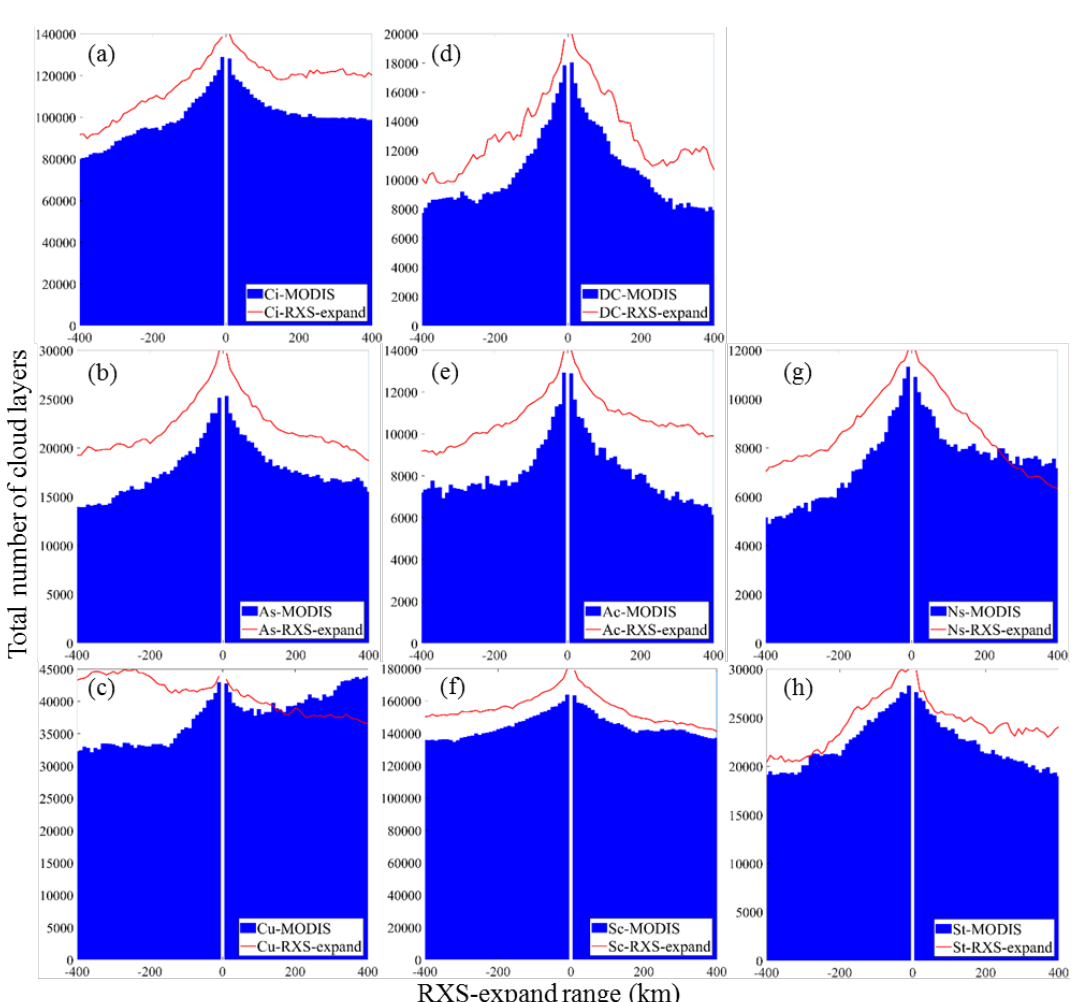
Figure 11. Comparison between cloud identification from MODIS and from the RXS-expand results up to 400 km on both sides of the daytime ground track. Each panel presents one of the eight cloud types, arranged from high, thin clouds to low, thick